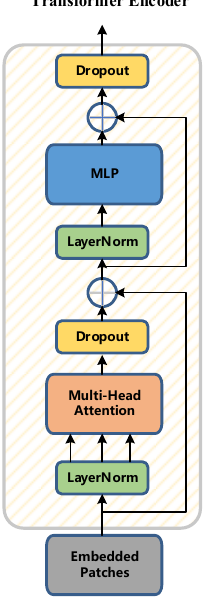
Figure 16. Transformer encoder diagram.